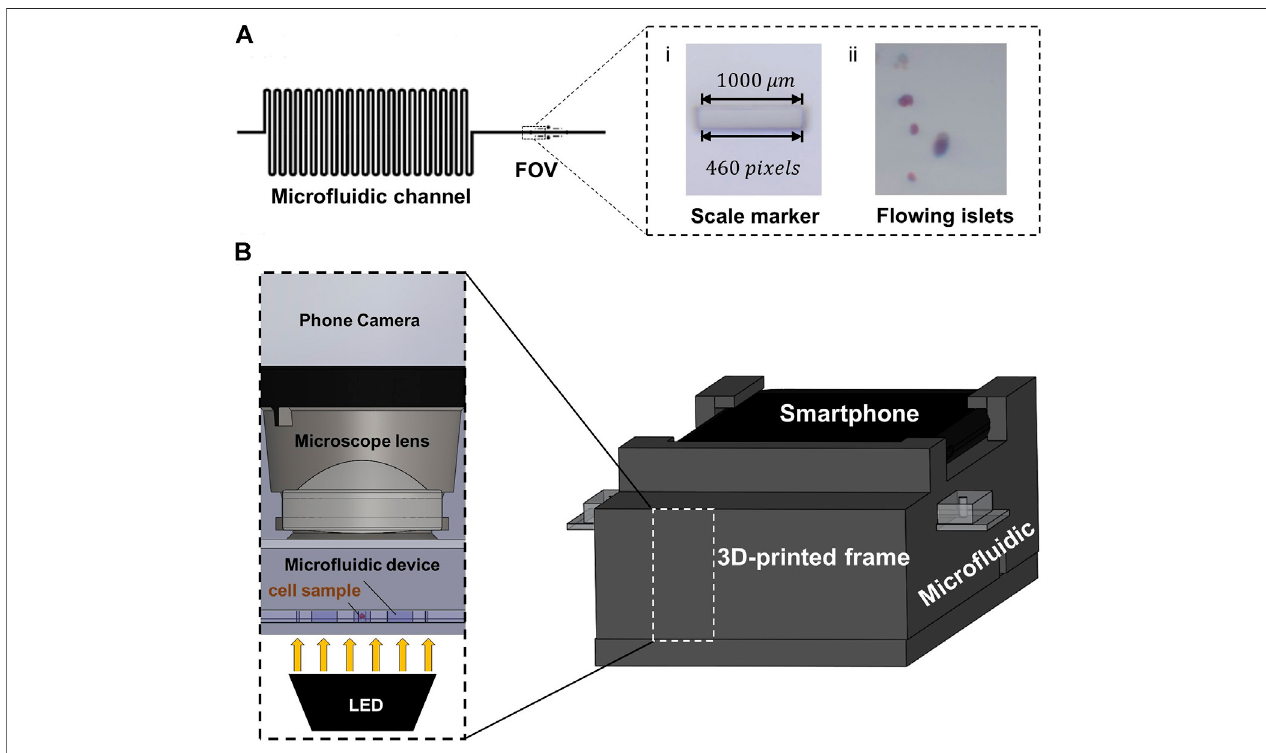
FIGURE 1 | (A) Design of the micro fl uidic device. (i) The 1,000 µm marker used to calculate scaling factor δ . (ii) An example of video captured by the smartphone camera. (B) Hardware design for the smartphone- fl uidics-based fl ow cytometry system. The 3D frame is designed to hold the smartphone at the top, the micro fl uidic device in the middle, and the LED light source at the